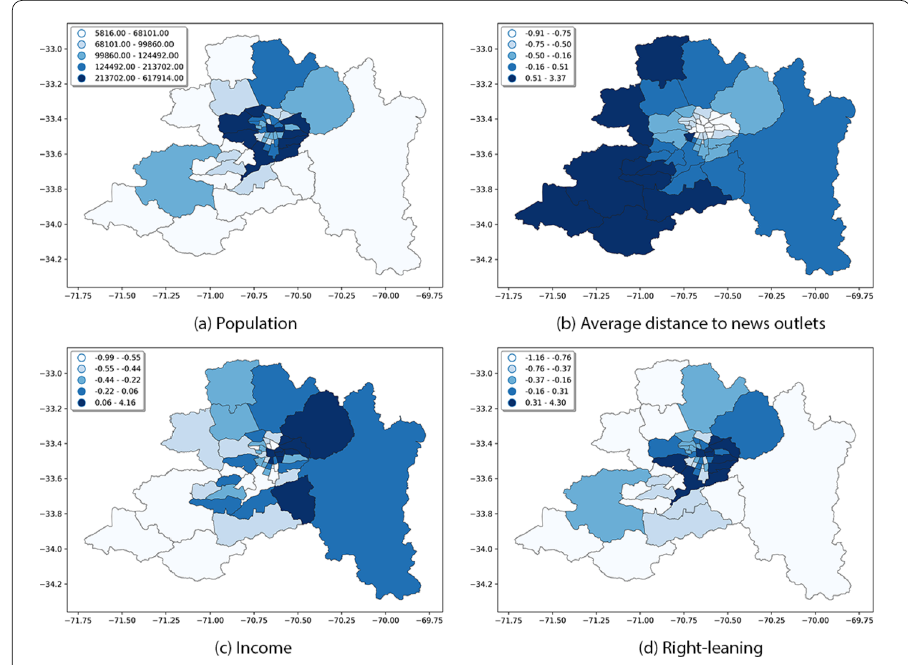
Figure 1 Summary of four different metrics for Santiago. From left to right, top to bottom: population, distance, income and